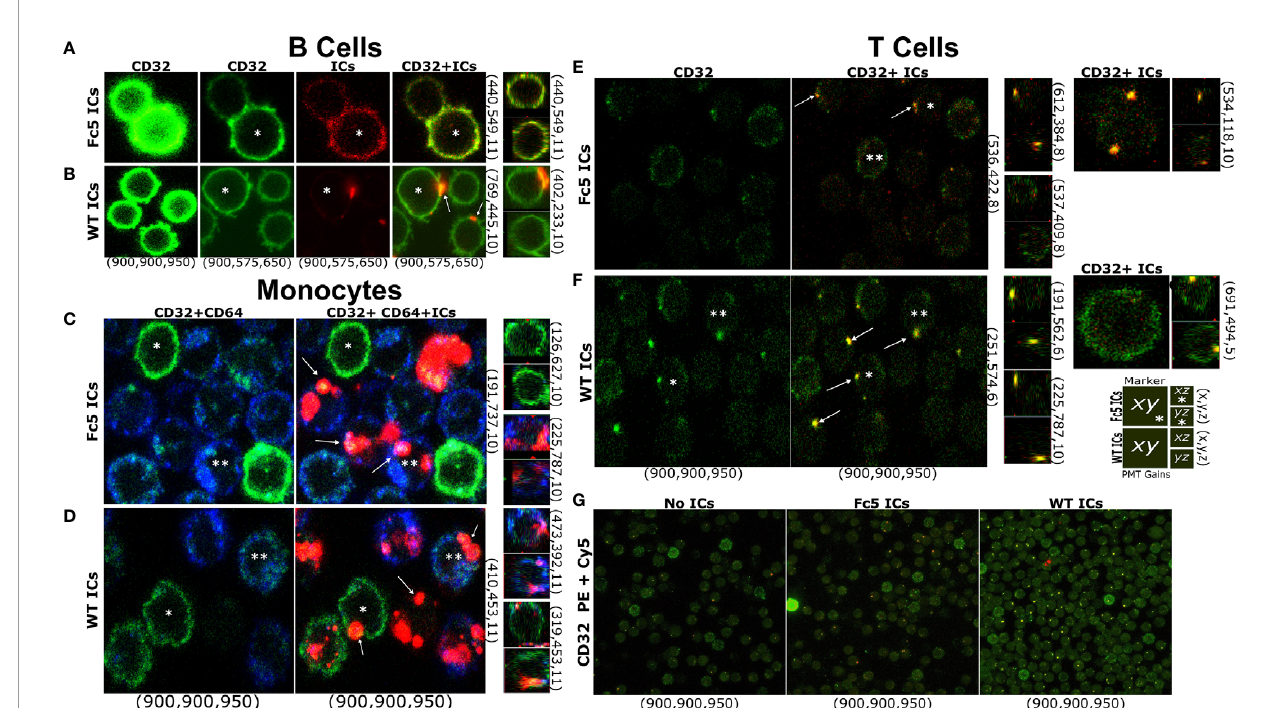
FIGURE 7 | T Cells Bind IgG Immune Complexes in a Manner Similar to B cells and Monocytes (A – G) Confocal microscopy of Fc g R display and IC staining in total T cells, B cells, or monocytes. (A – F) Left row labels indicate fl uorescent ICs (WT- or Fc5- IgG1-ICs). Top column labels refer to single-channel or merged images (Fc g RII (CD32): green; ICs: red; Fc g RI (CD64): blue). Bottom column labels indicate PMT gains used for each detector (PE: green, Cy5: red, BV421: blue-in this order) during image acquisition. Right row labels indicate the x-y-z plane coordinates. Larger and smaller images within each panel correspond to the x-y or x-z/y-z planes, respectively. A schematic legend summarizing the employed labelling system is shown. Asterisks help track the same cell in different images across a row. Arrows emphasize detected fl uorescent clusters. For (G) top and bottom labels indicate IC type and PMT gains,